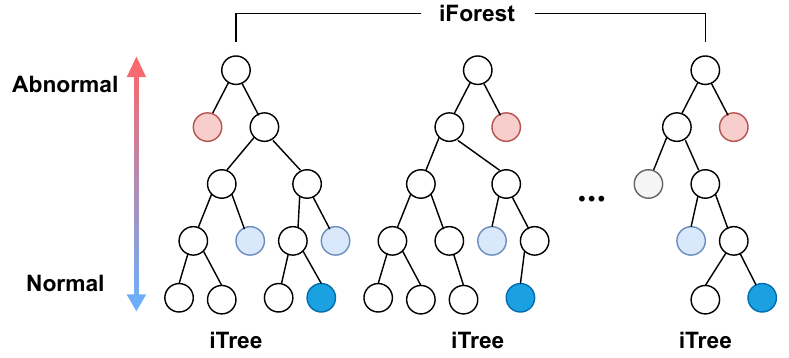
Figure 9. An illustration of